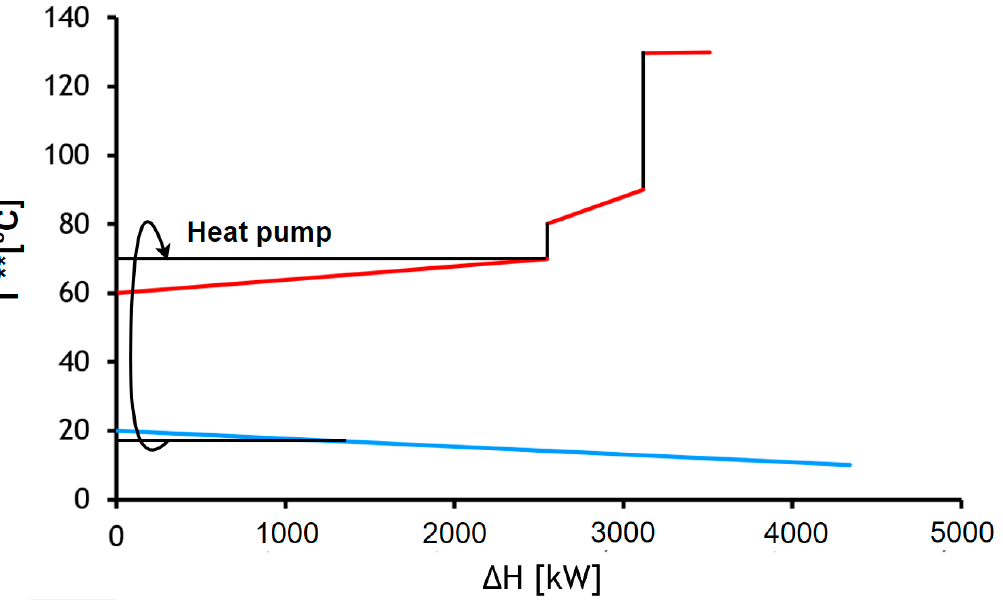
Figure 8. Site Utility Grand Composite Curve of the case study site with position of centralized heat